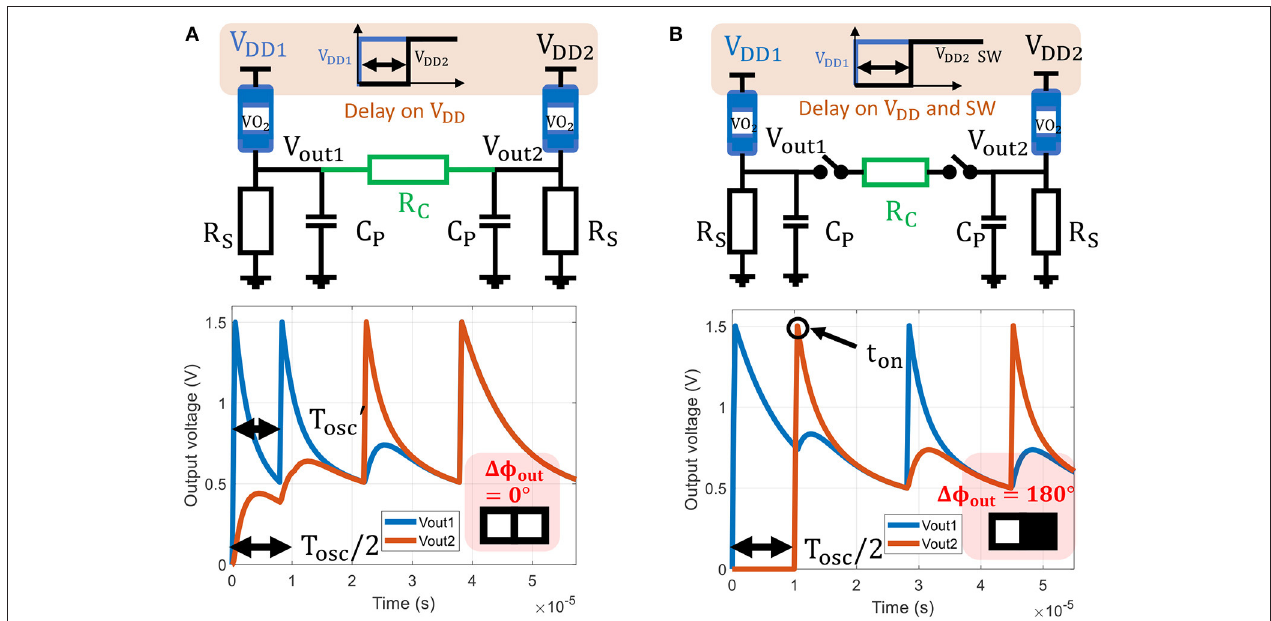
FIGURE 3 | (A) Two oscillators are coupled by a resistance R C =10 k (cid:127) without coupling switches in between. V DD 2 is turned-on 0.5 T osc after V DD 1 to set an initial phase of 180 ◦ . However, for t < 0.5 T osc the first oscillator period is decreased due to the shunt R C at its output node, and we cannot control the initial phase difference. The two oscillators are in-phase after convergence. (B) Two oscillators coupled with resistance R C =10 k (cid:127) and coupling switches between isolate the oscillators during initialization. This time, the 0.5 T osc input delay sets desired 180 ◦ initial phase state. Here, the switches are closed at t on = 0.5 T osc + t c such that V out 2 ( t on ) = V + . The two oscillators converge to an 180 ◦ phase state relation.